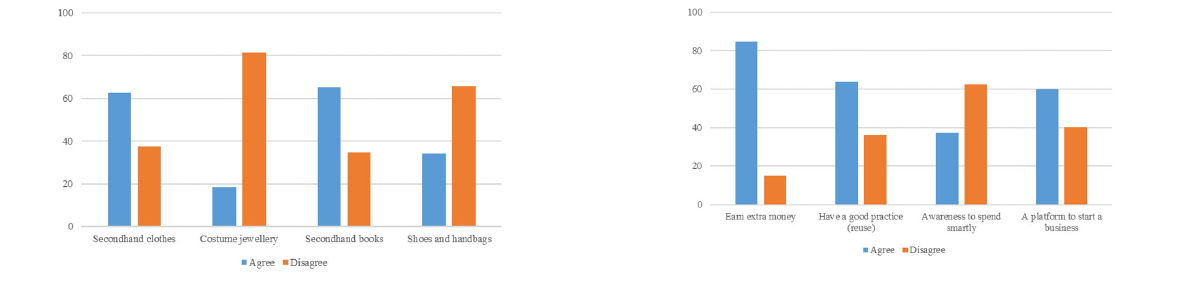
Fig. 2b. Respondents’ responses on Fig. 2a. Respondents’ responses on “What items would "Why do people plan to have garage sales in university?" you sell?”